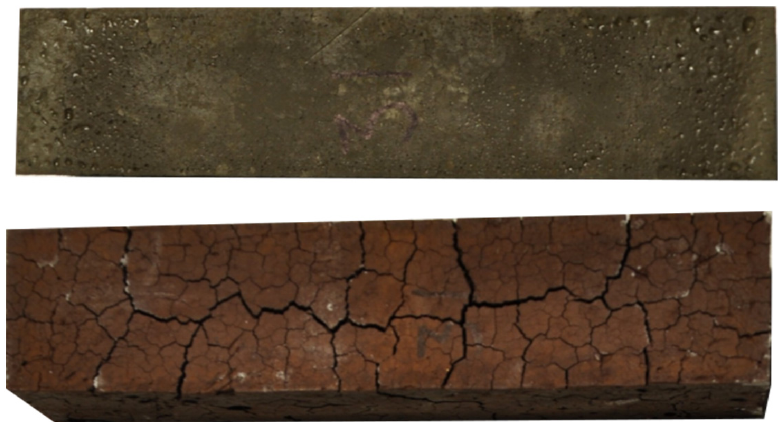
Figure 5. Top view of sample 31: up, before heat exposure; down, after heat exposure.